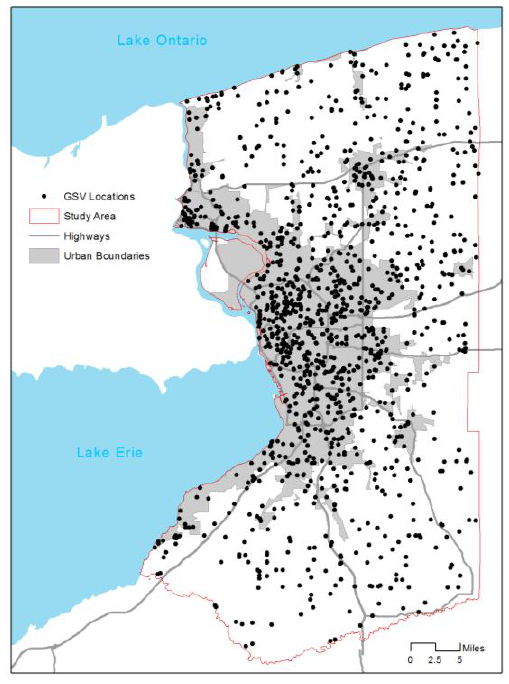
Figure 4. Sidewalk street image points and the study area.